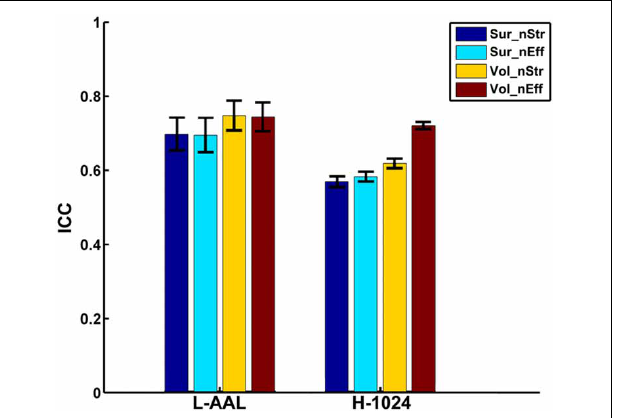
FIGURE 6 | The effects of different parcellation and resolution on the reliability of nodal strength and efficiency. The bars and errorbars represent the mean values and standard errors, respectively, of the ICC values of all nodal properties from different construction procedures. The ICCs of nodal strength and efficiency from surface- and volume-based networks were represented by Sur_nStr, Sur_nEff, Vol_nStr, and Vol_nEff,